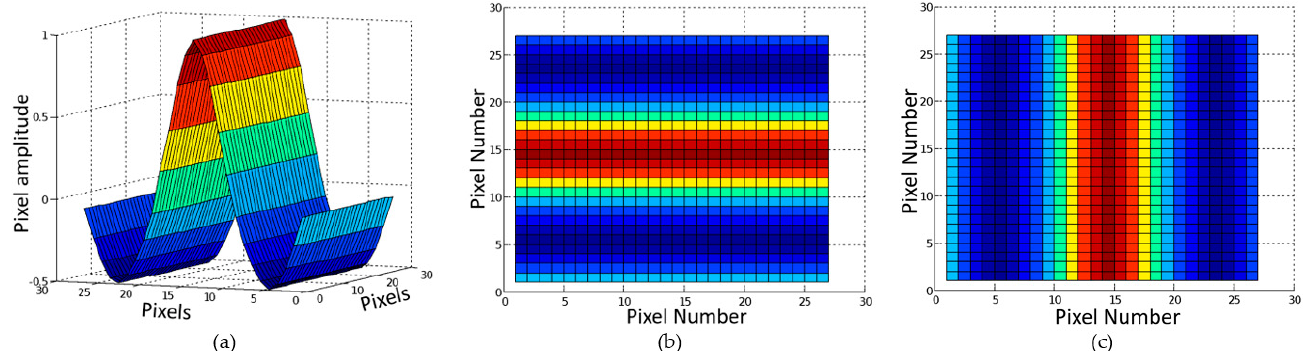
Figure 8. The 27 by 27 cosine kernel used in the design: ( a ) Cosine kernel shown in a three-dimensional plot; ( b ) top view of the cosine kernel in the horizontal (0°) direction; ( c ) top view of the cosine kernel in the vertical (90°) direction.